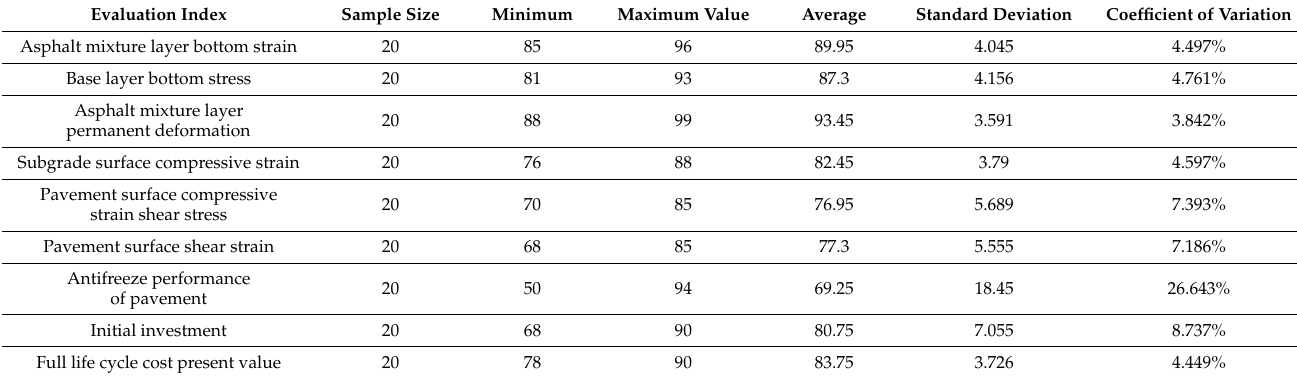
Table 3. Results of the first round of expert